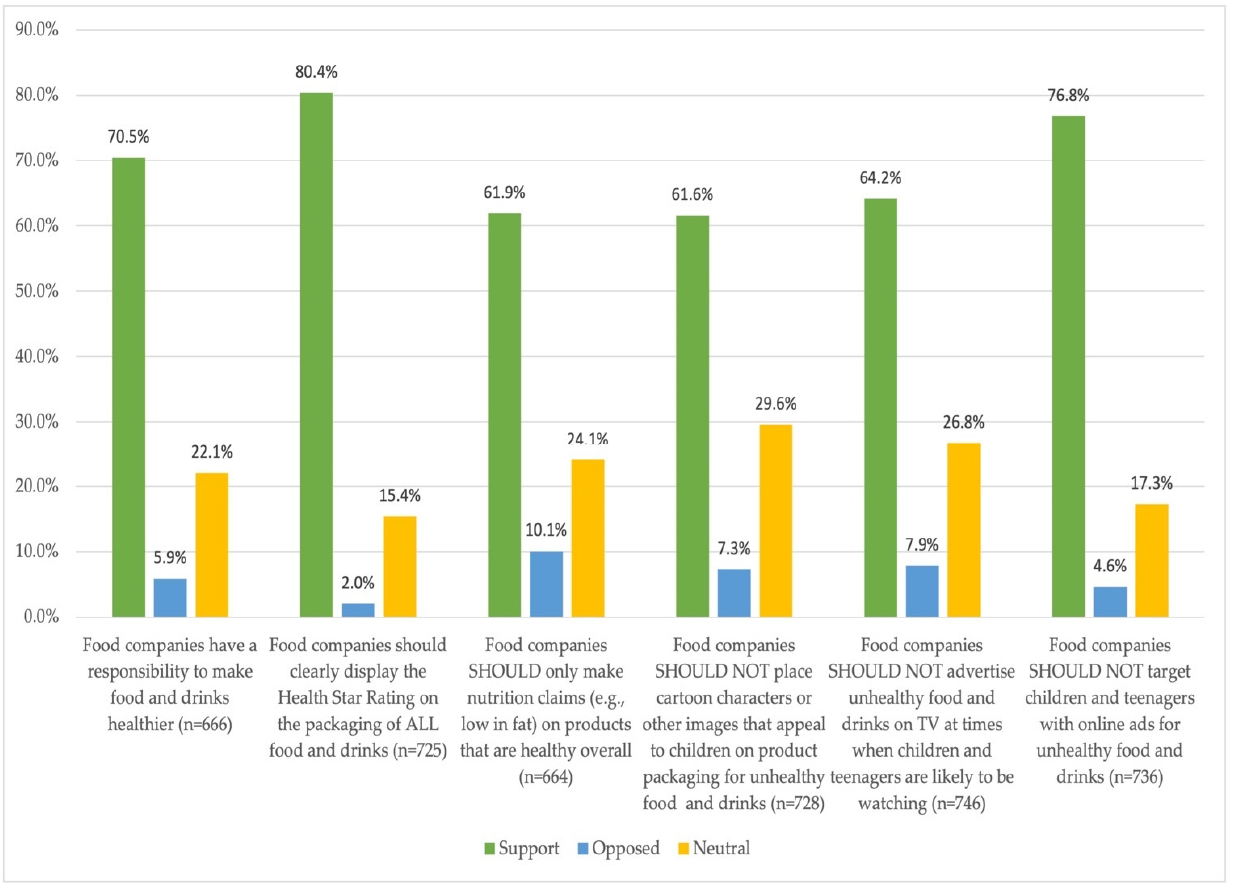
Figure 1. Proportion of Australian public support for nutrition-related actions by food companies (%), IFPS, 2020. Weighted data used for total number of respondents in each category.